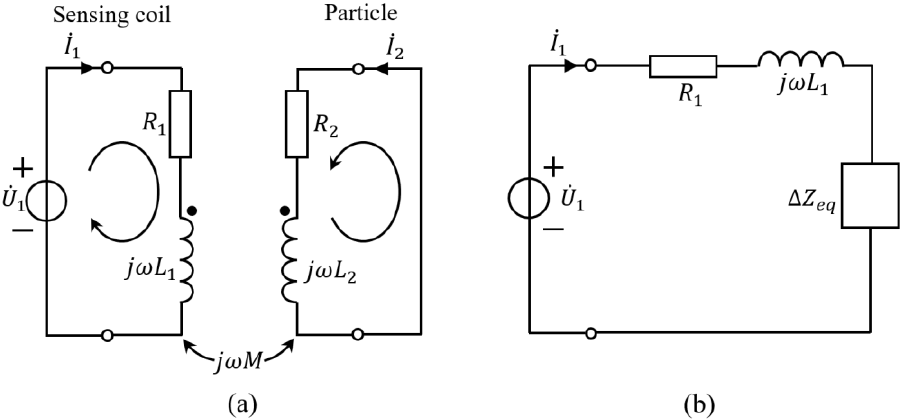
Figure 1. Illustration of the eddy current effect induced in the particle by the sensing coil with ( a ) separate circuit model and ( b ) an equivalent circuit.